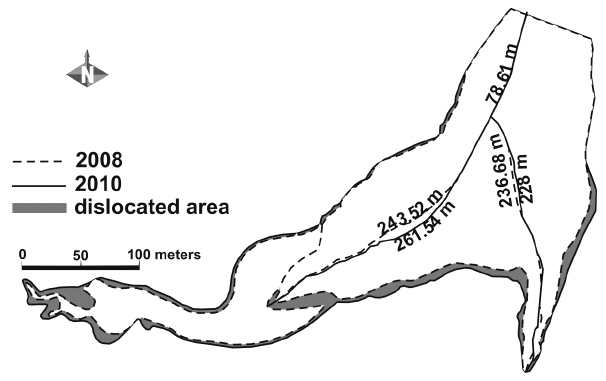
Fig. 18. The areas of separation and change in the Cucuteni-Baiceni river bed in the gully (2008–2010).